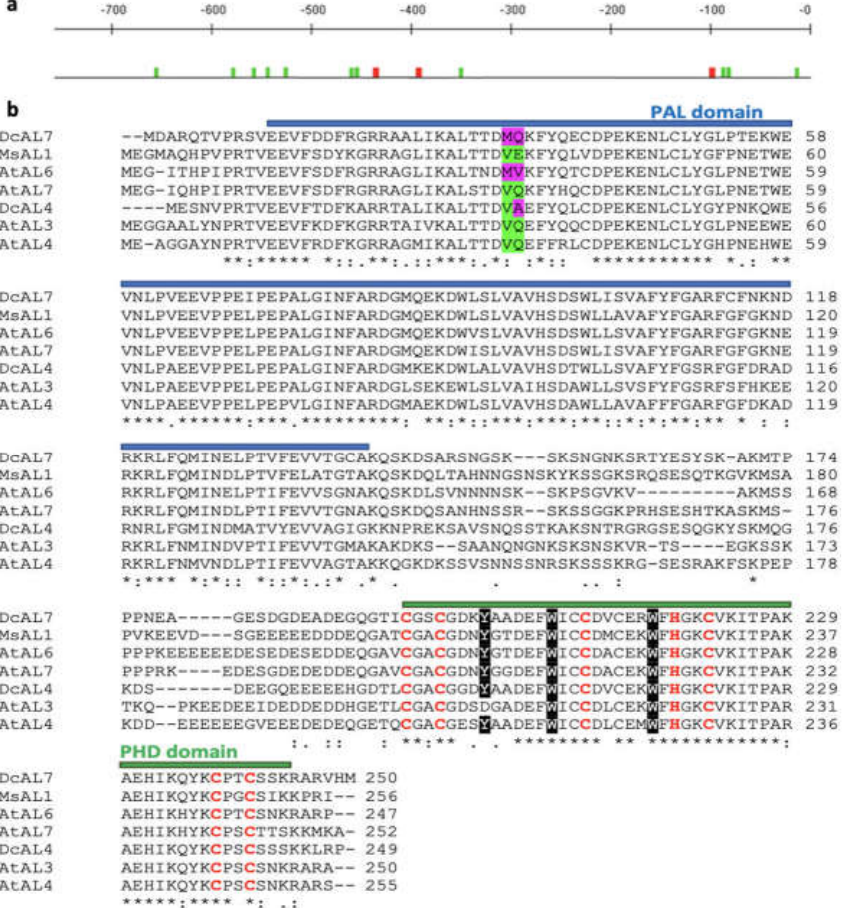
Figure 1. Alignment of plant ALs and ALFIN regulatory elements in the DcPSY2 promoter. ( a ) The 769 bp promoter DcPSY2 [8] presents 11 ALFIN (green) and three ABRE (red) responsive elements. ( b ) Sequence alignment of DcAL4 and DcAL7 from D. carota , MsAL1 (GenBank: AAA20093.2) from M. sativa , and AtAL3 (Gene ID: 823316), AtALAL4 (Gene ID: 832690), AtALAL6 (Gene ID: 814776) and AtAL7 (Gene ID: 838013) form A. thaliana . The PAL domain is highlighted in blue and the PHD domain in green. Conserved amino acids within the PHD domain are highlighted in red (Cys4HisCys3) and black (Tyr-Trp2). Variations in the capability to bind G-Rich motifs in the PAL domain are highlighted in green and purple. * = Identical amino acids; : = conserved; . = semi-con- served, respectively.